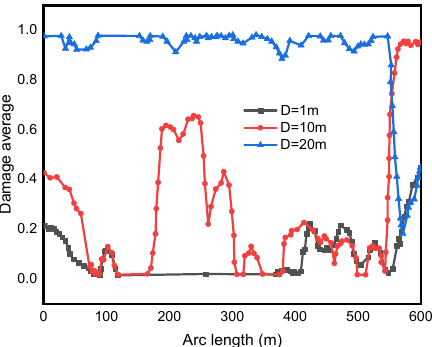
Figure 18. Damage curves of dam crest at different blasting distances. Table 4. Arch dam body damage at various blasting distances.